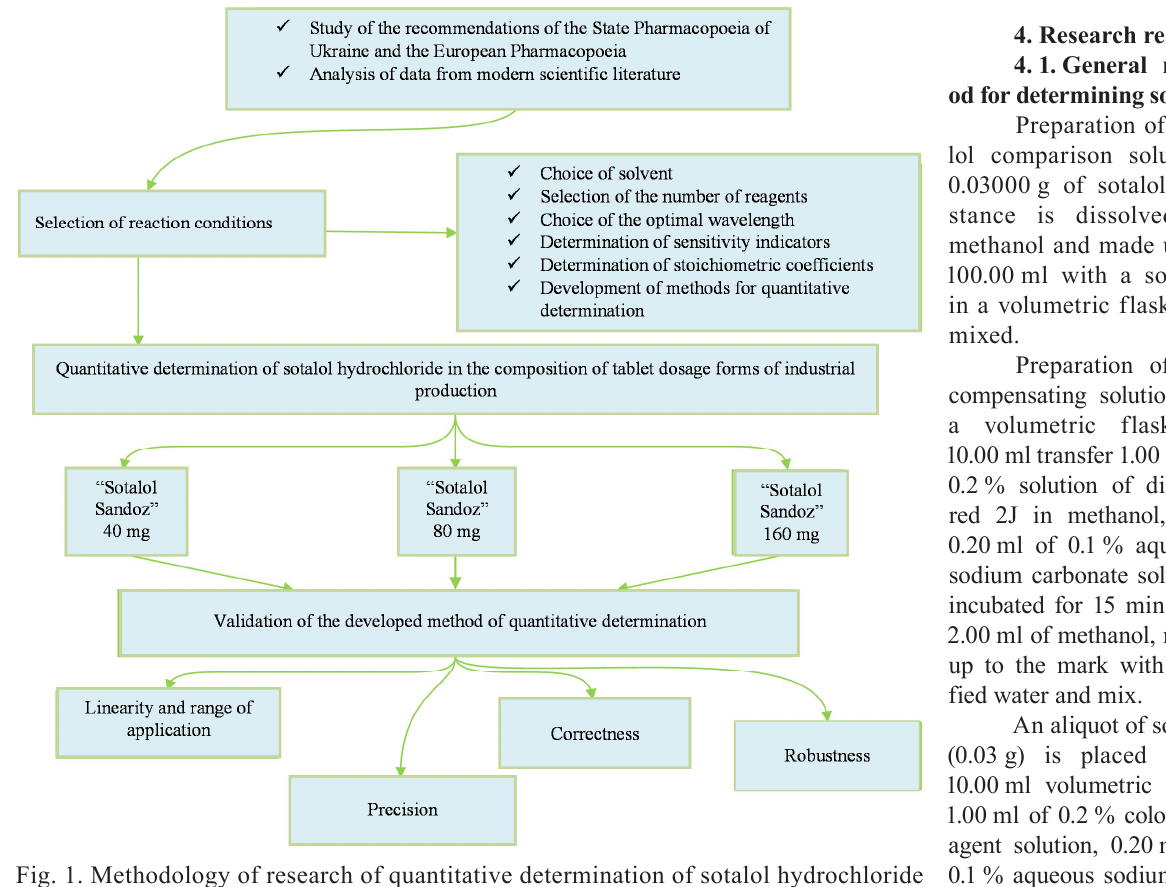
Fig. 1. Methodology of research of quantitative determination of sotalol hydrochloride in dosage forms of industrial